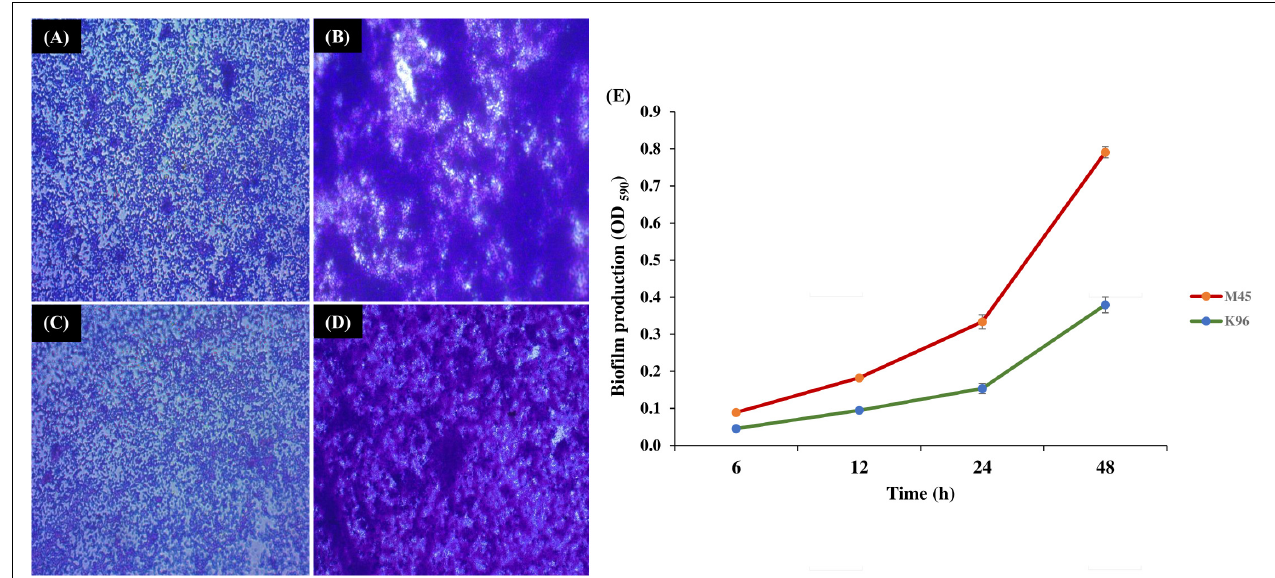
FIGURE 4 | Biofilm formation by potent bacterial isolates. Light microscopy images of biofilm formation by (A,B) M45 ( Pseudomonas sp.), and (C,D) K96 ( Stenotrophomonas sp.) at 24 and 48 h, respectively. The biofilms were stained by crystal violet; (E) Quantification of biofilm production for 48 h by M45 and K96 after elution of crystal violet stain by ethanol.